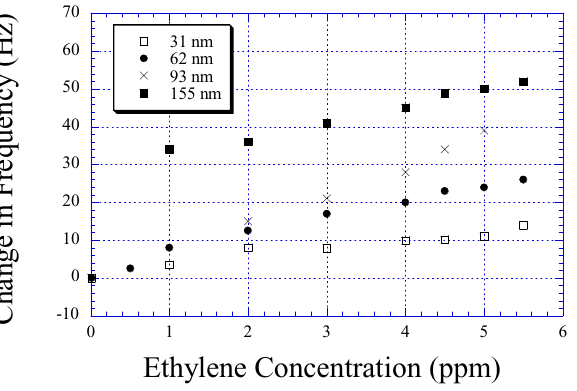
Figure 6. Shift in measured resonant frequency of ethylene sensors at low ppm